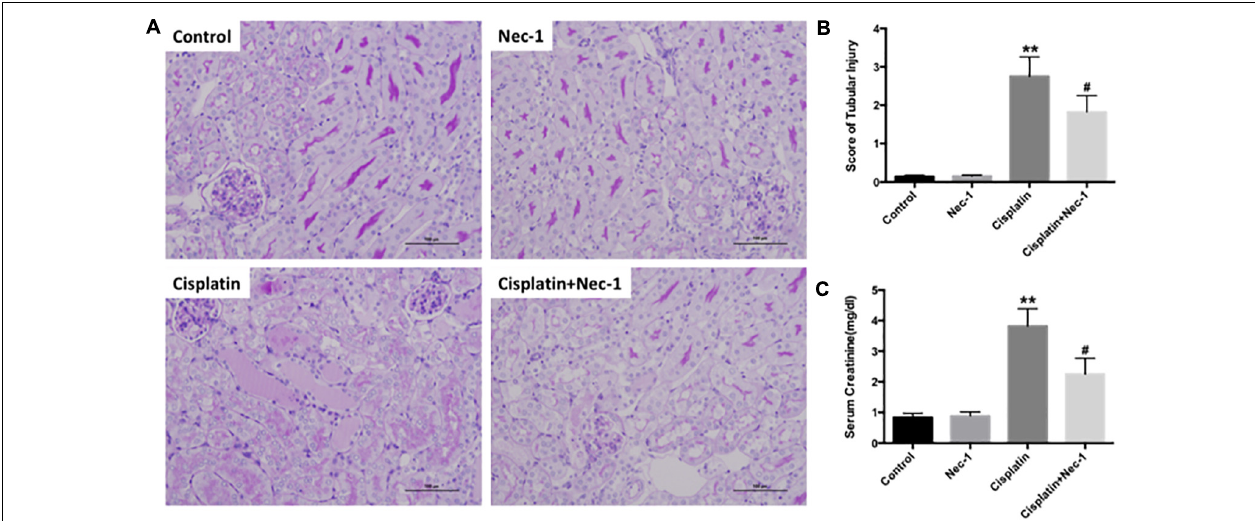
FIGURE 1 | Nec-1 attenuates the cisplatin-induced nephrotoxicity in mice. (A) Representative photomicrographs of renal tissues submitted to PAS staining ( × 200). (B) Tubular injury scores provided semi-quantitative data of the morphological changes by histological grading system. (C) Changes of serum creatinine among the four groups. The data are presented as means ± SD ( n = 8). ∗∗ p < 0.01 versus control group; # p < 0.05 versus cisplatin group.